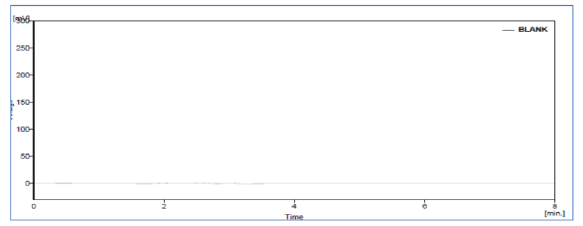
Figure 3: Blank chromatogram for specificity by using mobile phase.